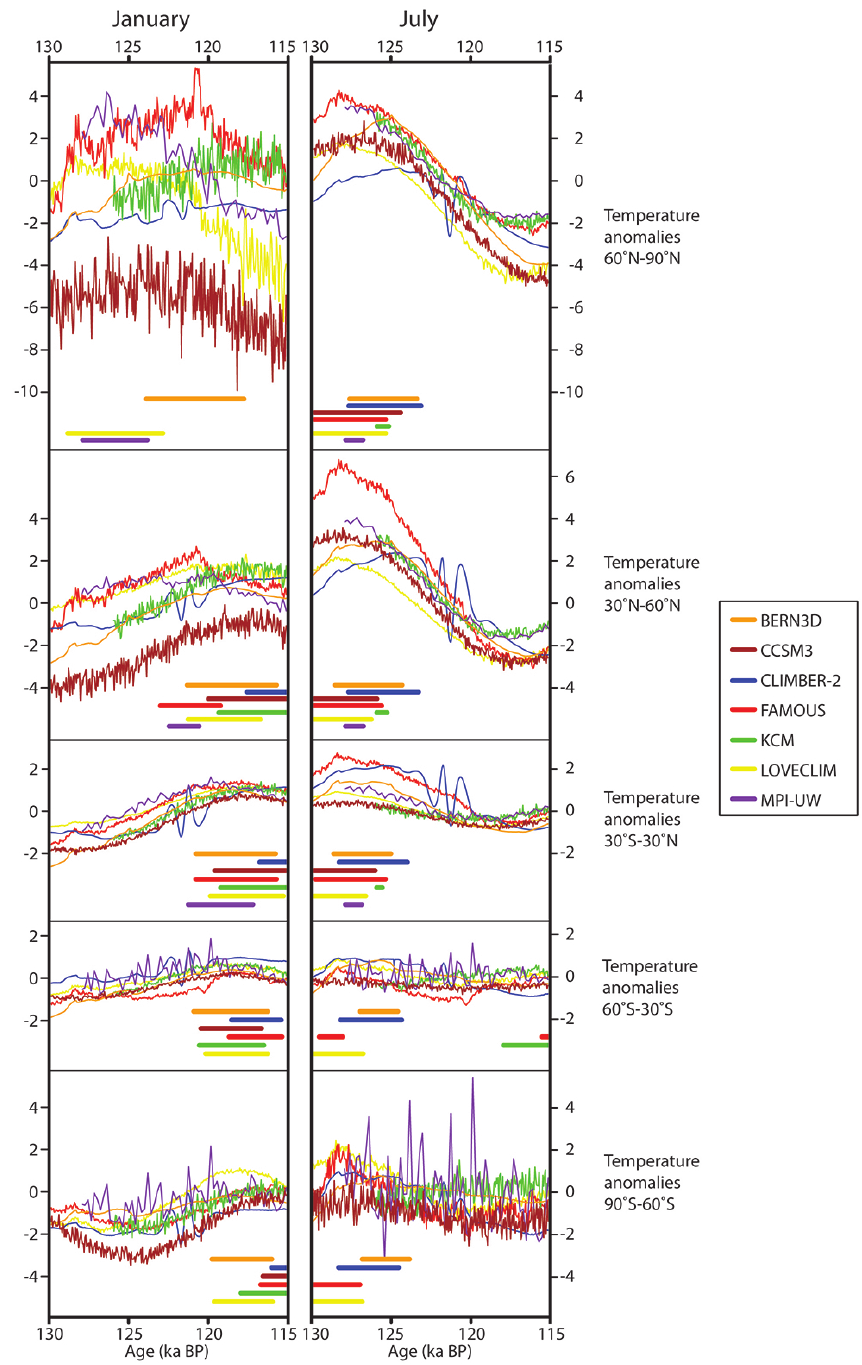
Fig. 2. Simulated 130–115kaBP January and July surface air temperature anomalies (K) by the seven climate models for five different latitude bands. All temperatures are anomalies relative to pre-industrial values. The temperature series are 50yr averages. The horizontal bars accompanying the surface temperature anomalies are the periods of maximum warmth for each individual simulation. We define maximum warmth when the temperature is between the upper limit (which is the absolute temperature maximum) and the lower limit (which is the upper limit minus 10 % of the differences between the LIG maximum and minimum values). Note that these calculations are not performed on the 50 yr average-data but on the values from a polynomial which is fitted to the temperature-series in order to get a robust, multi-millennial signal. The individual period of maximum warmth is only shown if the maximum temperature along the polynomial is outside the 1 σ range of the LIG mean. Note that in all simulations shown in this figure a fixed-day calendar was